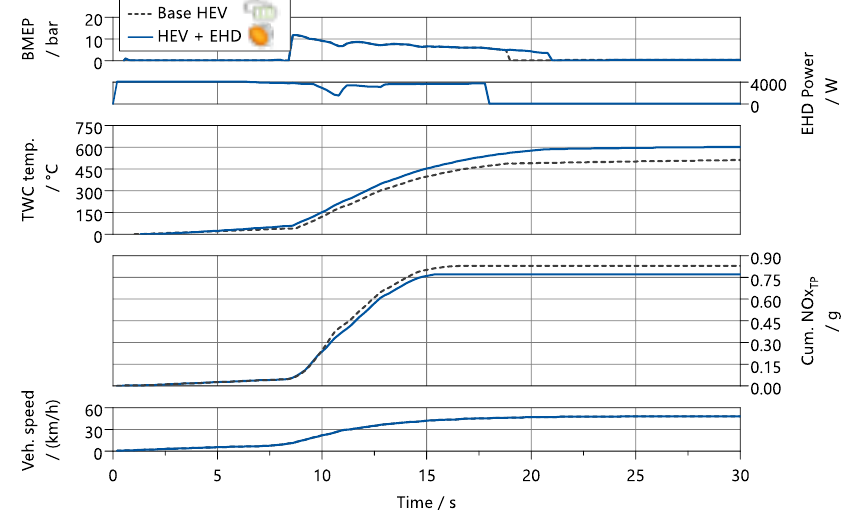
Figure 11. Start of the High Altitude cycle with HEV and